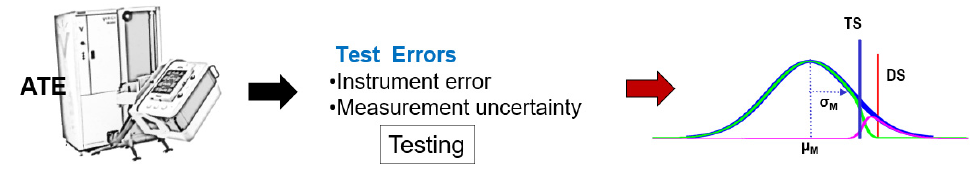
Figure 5. Error factors that affect the test results.